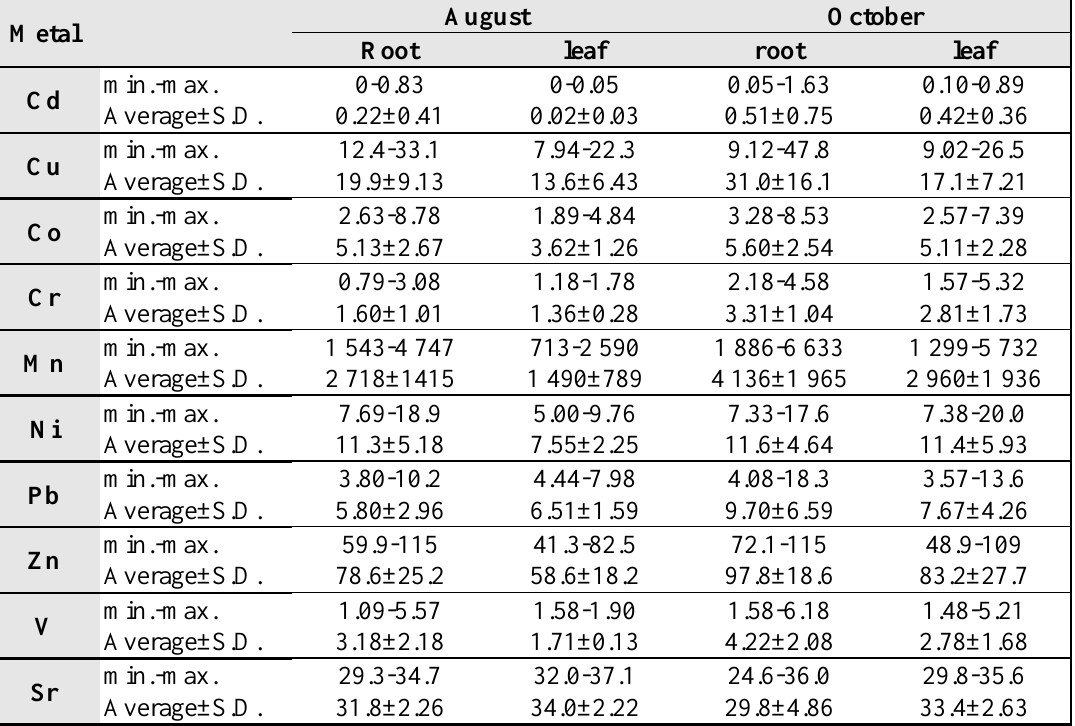
Table 2. - Seasonal changes in metal concentrations (mg/kg dw) in the root and leaf of L. minor ; minimum and maximum concentrations and average concentrations ± standard deviation